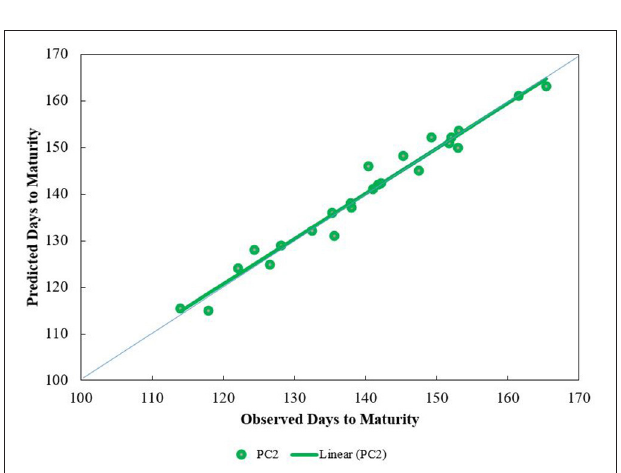
FIGURE 8 | Trend lines for predicted vs. observed days from emergence to maturity at three sites and four sowing dates. Predictions are based on the Wang and Engel algorithm (Equation 1) modified by photoperiod effect (Equation 3), the latter using a photoperiod coefficient of